Question: Name the type of graph shown.
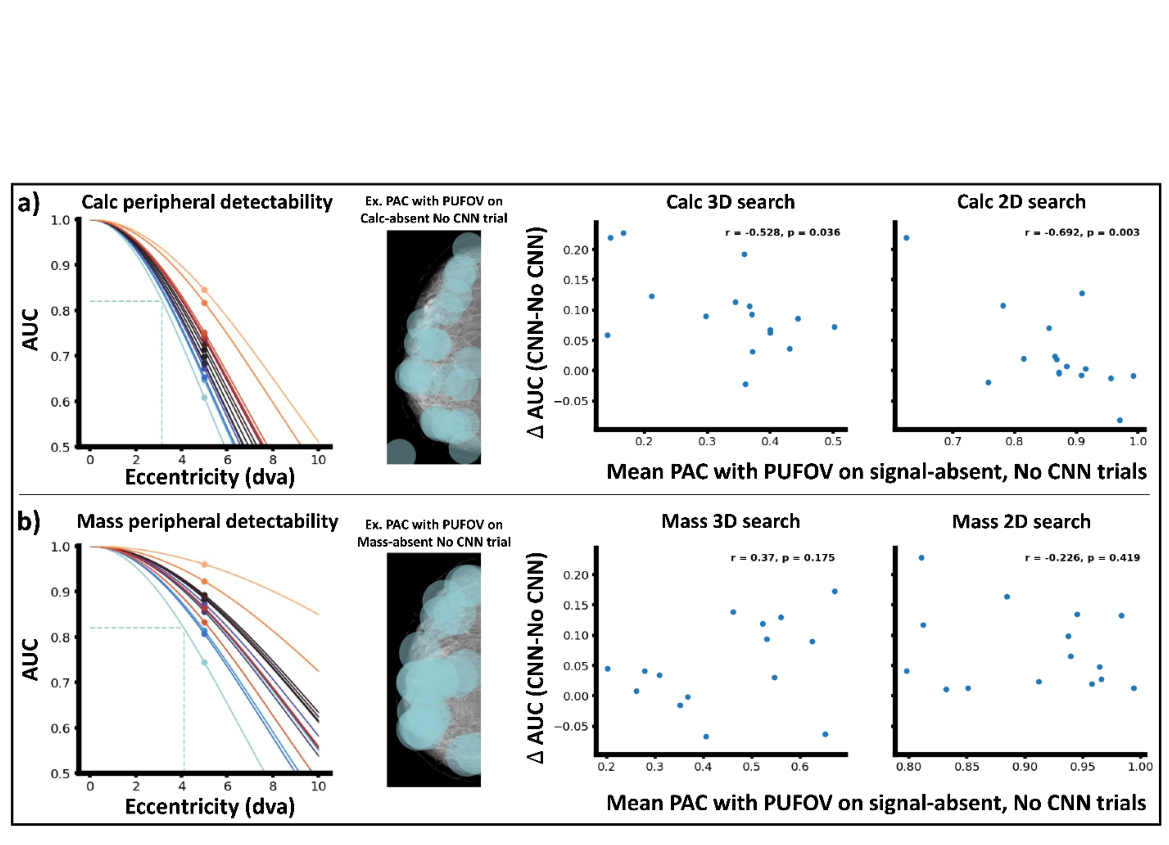
Answer: scatter